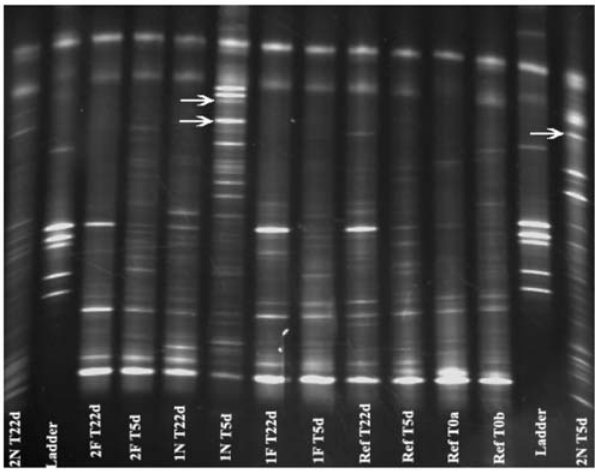
Figure 2. Denaturing gradient gel electrophoresis (DGGE) image of one coral colony ( # 1) at all sites (Far-1&2, Near- 1&2, and Reference) across all time points (T-0, T-5 days, T-22 days). Arrows indicate Desulfovibrio bands that were sequence verified. There were two separate fragments sampled from each colony at T0. Both samples are shown on this gel as T0 a and b. Samples from the high effluent sites (Near-1&2) at T-5 days were the only visible Desulfovibrio bands. phylotype distributions were fairly similar among Reference, Far-1 and Far-2 for all time points and Near-1 & 2 for T-0 and T-22 days. The other clone library pattern that revealed itself was an apparent increase in diversity at the high effluent sites at T-5 days. The number of classes represented at the Near sites increased at T- 5 days, while the number decreased at the Reference and Far sites (Fig. 4). The Shannon-Wiener index of diversity also increased by 1.7954, from 1.5358 at T-0 to an average of 3.3312 at T-5 days, at the high effluent sites. In contrast, the values for corals at the low effluent sites increased by an average of 0.5140, and by 0.3636 at the reference site. Discussion There are several lines of evidence supporting our hypothesis that fish pen effluent induces changes in coral-associated bacterial Table 2. Desulfovibrio Presence/Absence.